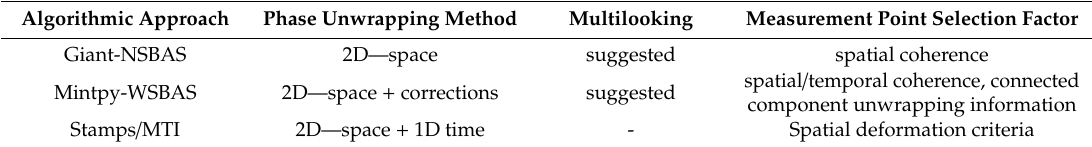
Table 1. Processing factors for the selected TSInSAR